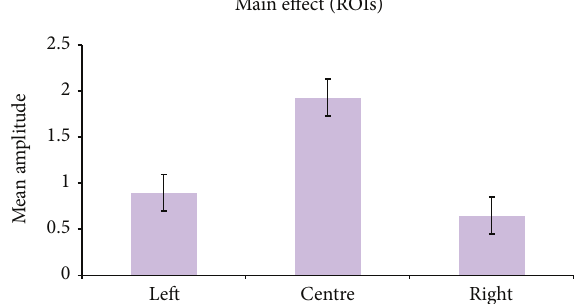
Figure 3: Mean amplitudes of ERPs elicited in the left, central, and right ROIs, in the whole group. Error bars represent standard